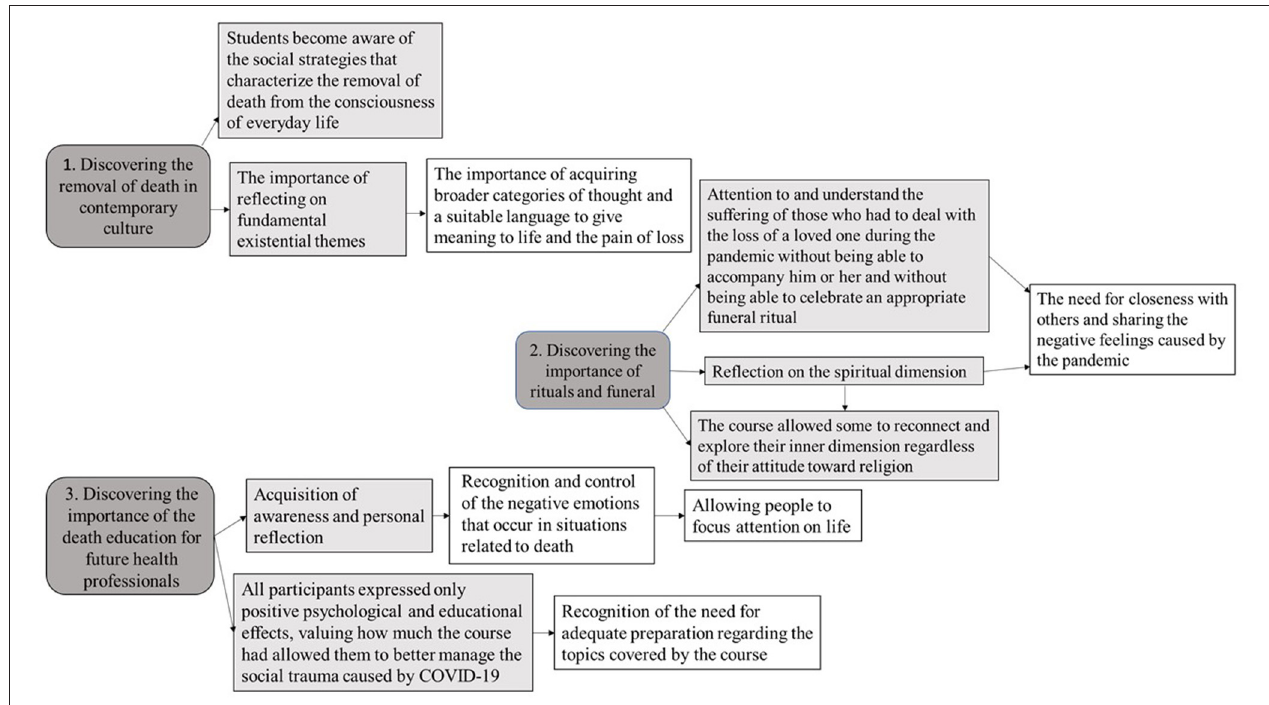
FIGURE 2 | Findings of qualitative data analysis. Main themes and their